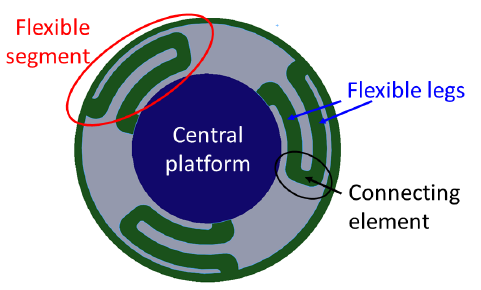
Figure 4. Ortho-planar spring: bottom view of the ortho-planar spring showing the structure of the flexible